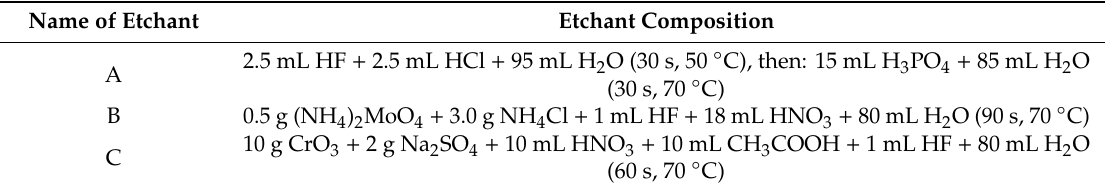
Table 3. Di ff erent reagent compositions with separate sequences of